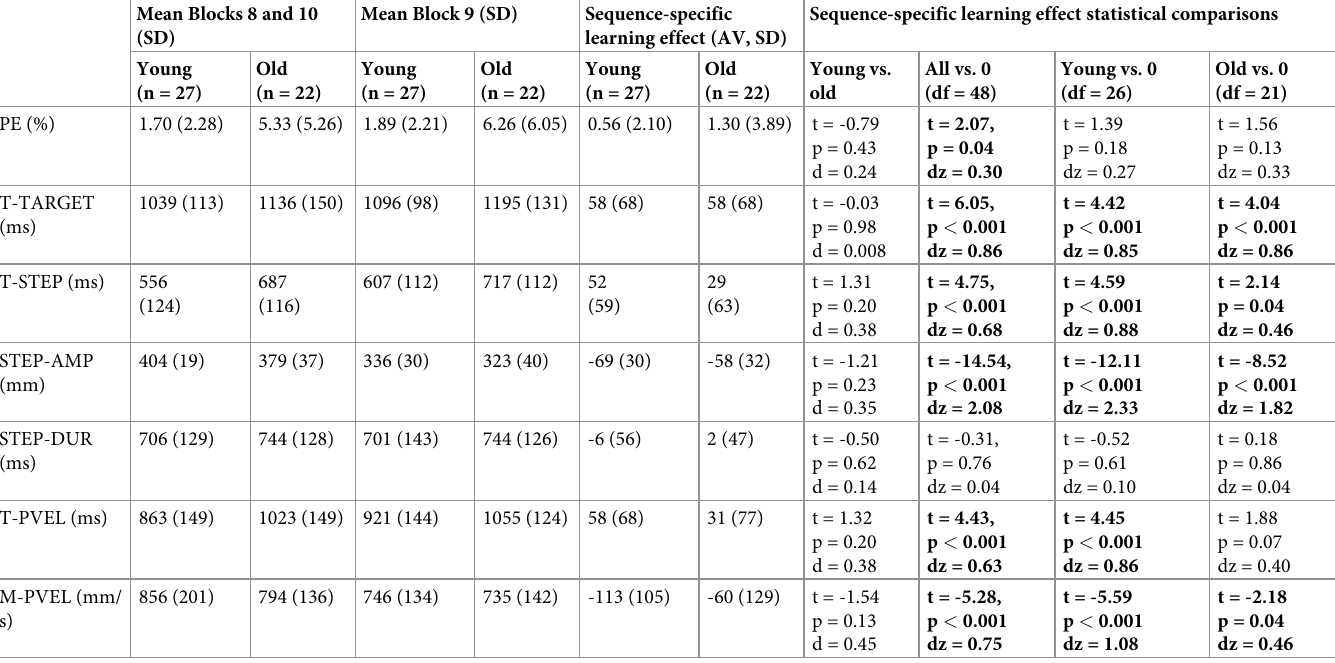
Table 3. Descriptive statistics, age comparison and sequence-specific learning effects in Experiment 2. Mean Blocks 8 and 10